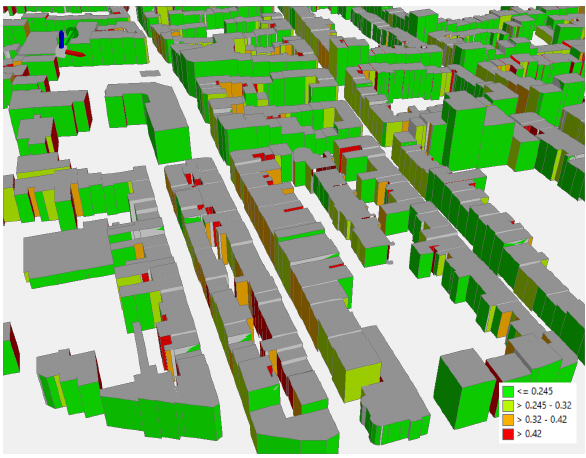
Figure 6. Diffuse irradiation per hyper-point [kWh/a]